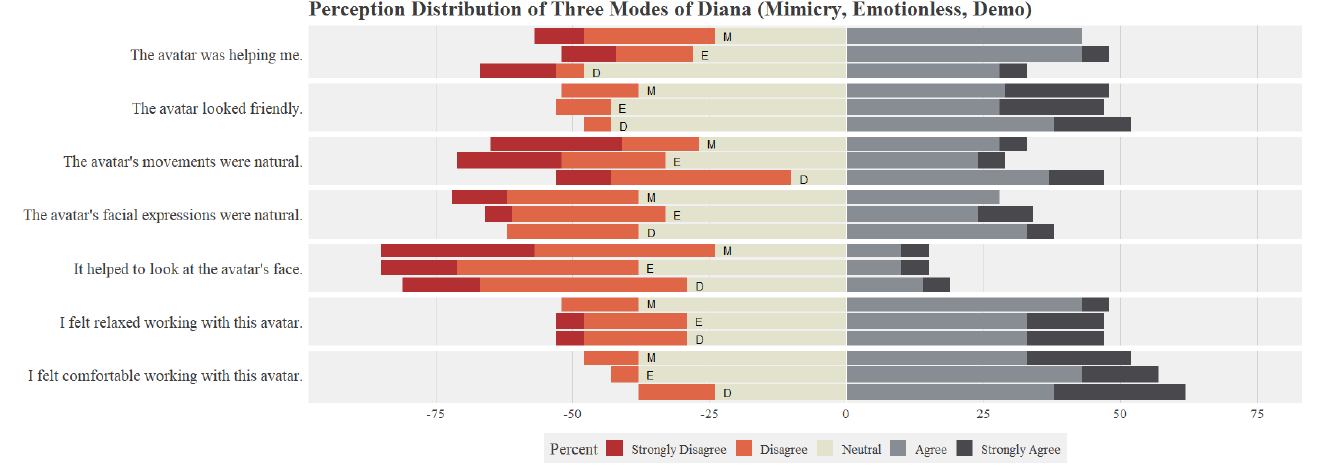
Figure 16. Diverging stacked bar chart of the percentages of users’ perceptive